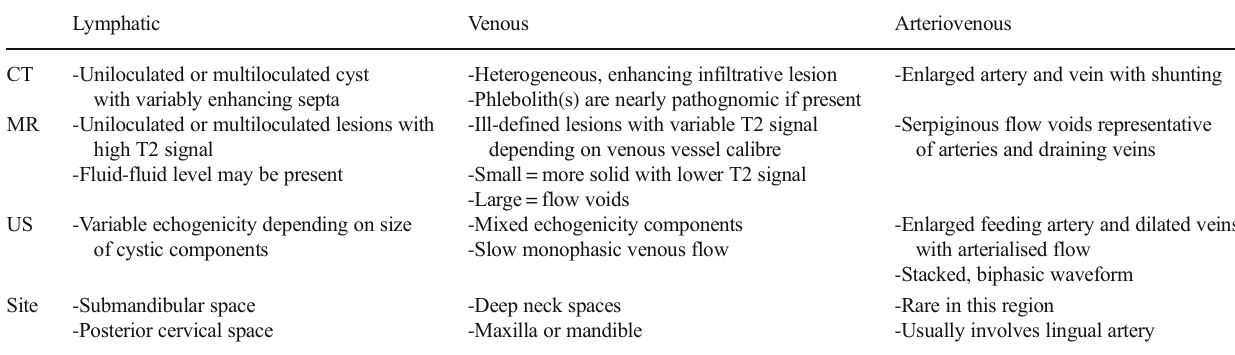
Distinguishing imaging features among vascular malformations of the sublingual and submandibular spaces